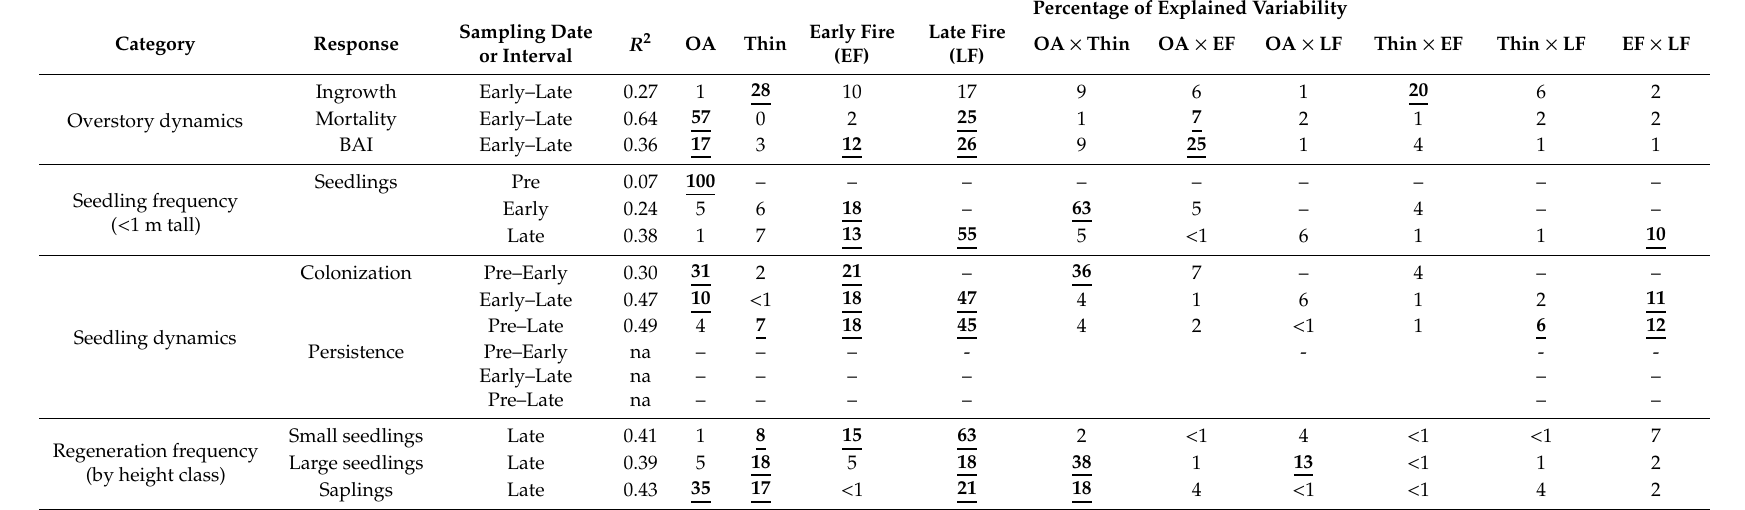
Table 2. Summary of model results. See Table 1 for explanations of response variables and Tables A1–A6 (Appendix A4) for full model output. For the linear model of BAI, R 2 is the proportion of the variability explained by the full model. Values for individual terms are percentages of explained variability, summing to 100%. For GLMs (all other responses), R 2 is one minus the ratio of the model’s deviance from being the best (perfect) and worst (null, intercept-only) model. Values for individual terms are percentages of deviance improvement with each added term, summing to 100%. Significant terms ( p < 0.05) are underlined and bold. Terms that were not tested for a particular response are denoted by a dash, (cid:48) – (cid:48) . Sampling dates are Pre (2000 / 2001), Early (2004 / 2005), and Late (2015). Results for persistence are not shown (na) as models did not converge due to low sample